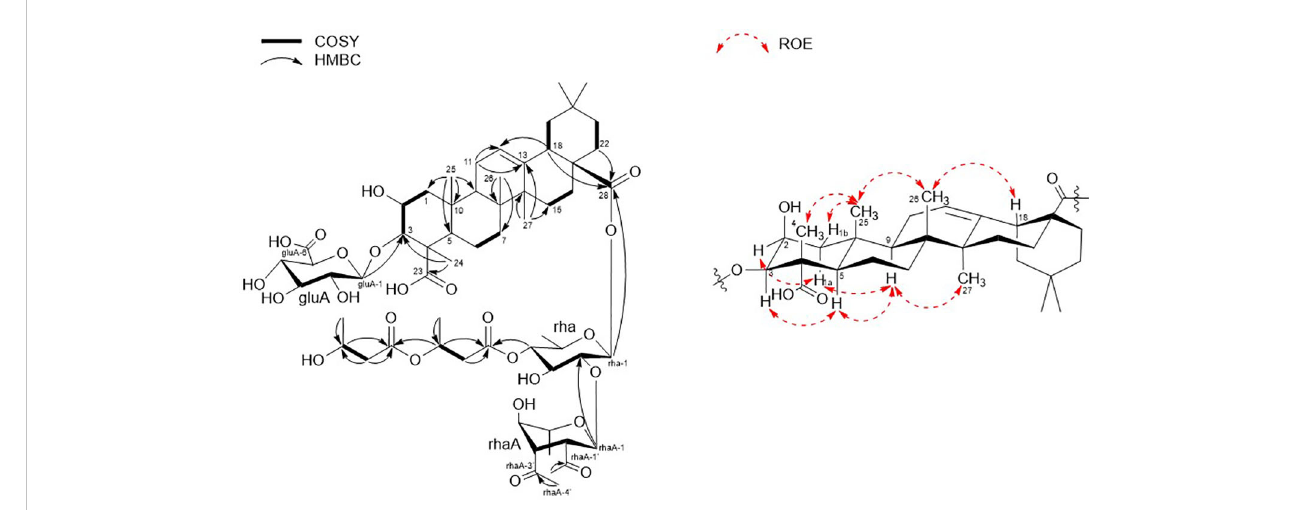
FIGURE 2 Key COSY, HMBC, and ROESY correlations of 1